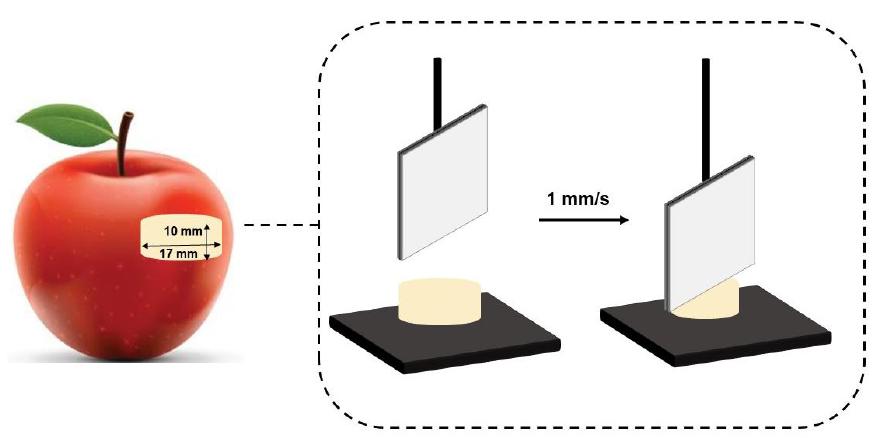
Figure 2. Schematic representation of the cutting test procedure.